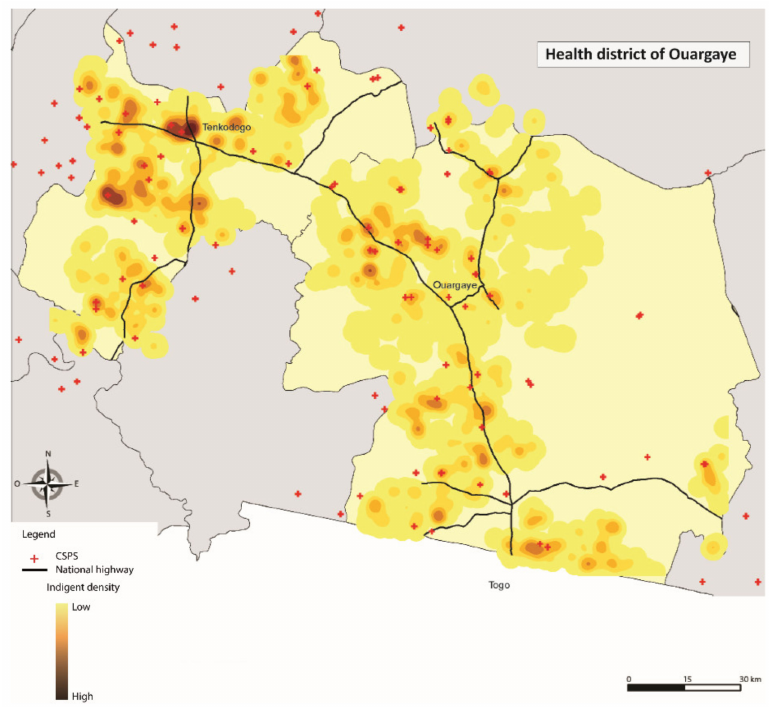
Figure 4. Geographical concentration of the respondents in Ouargaye.